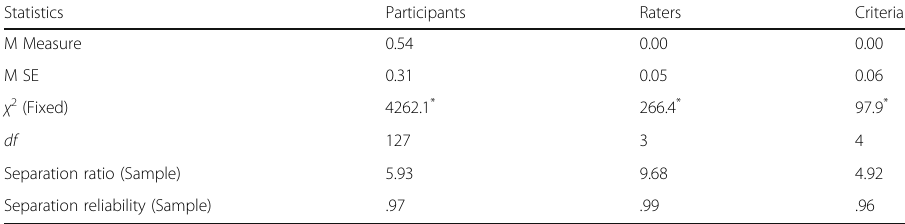
Table 1 Summary statistics for the MFRM analysis of the initial 9-point rating